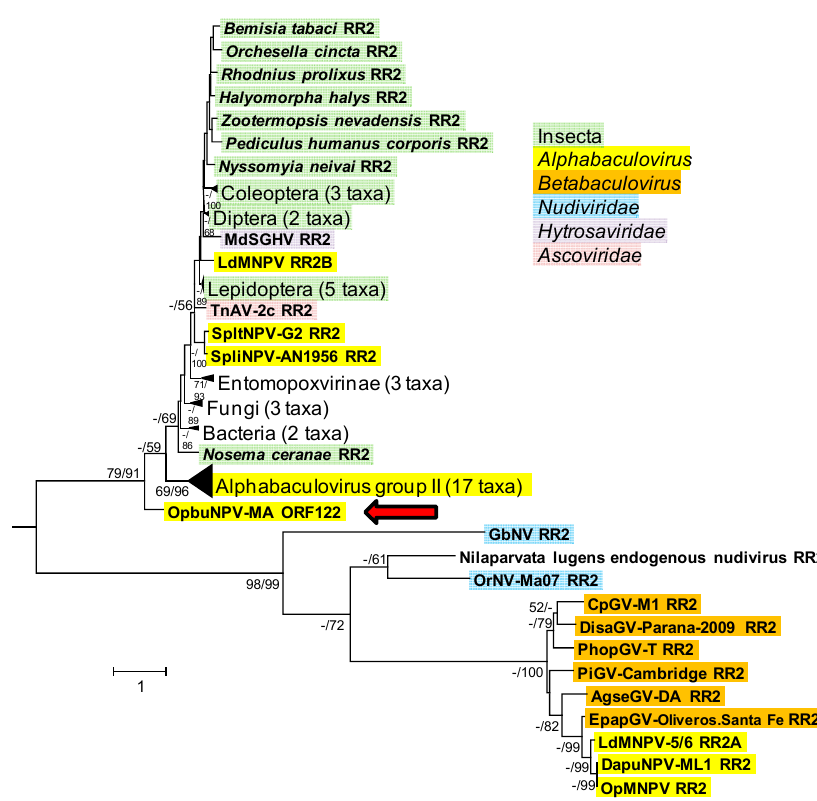
Figure 9. Phylogenetic inference from aligned viral and cellular ribonucleotide reductase small subunit (RR2) homologs. An ML phylogram inferred from the alignment of RR1 amino acid sequences is shown with bootstrap values (>50%) at interior branches for ME and ML analysis (ME/ML) where they occur. The sequence for Bacillus thuringiensis IBL200 RR2 (GenBank accession no. EEM97378) was included as an outgroup. The classification of each taxon is indicated with a color-coded text background, except for unique taxa of subfamily Entomopoxvirinae , kingdoms Fungi and Bacteria, and the Nilaparvata lugens endogenous nudivirus (which is not actually classified as a nudivirus). Branches for RR1 sequences from the entomopoxviruses, the fungi, the bacteria, the insect orders Coleoptera, Diptera, and Lepidoptera, and group II alphabaculoviruses are collapsed, and the numbers of taxa in each of these nodes are indicated in parentheses. The OpbuNPV sequence is indicated with a red arrow. The sequences in this tree and their accession numbers are as listed in Table S1.